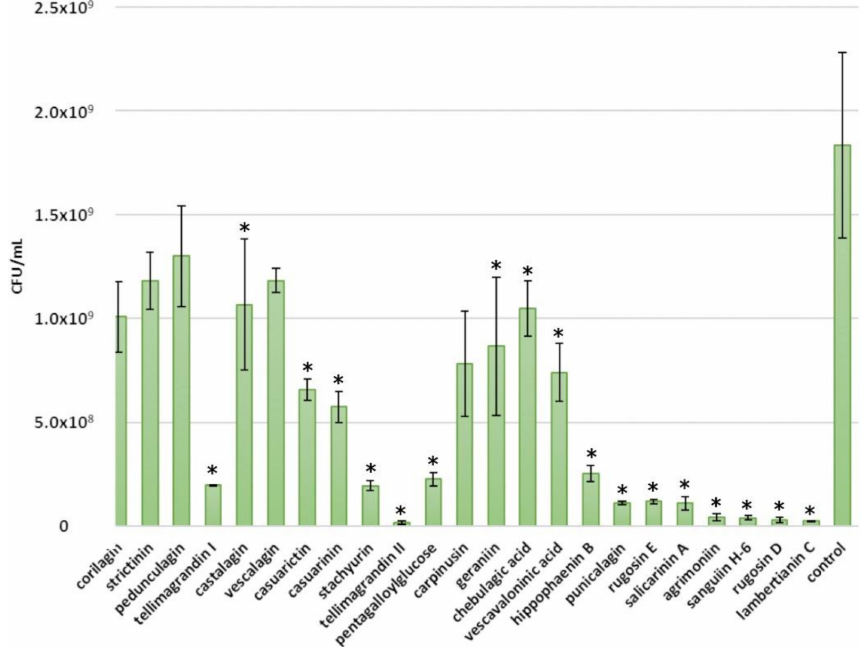
Figure 4. Growth of Escherichia coli after a 24 h treatment with 0.5 mM ellagitannin and pentagalloylglucose solutions. Growth is expressed as CFU / mL (mean values and standard deviations, n = 3). All 23 tested tannins are in the order of increasing molecular weight; * p < 0.05.